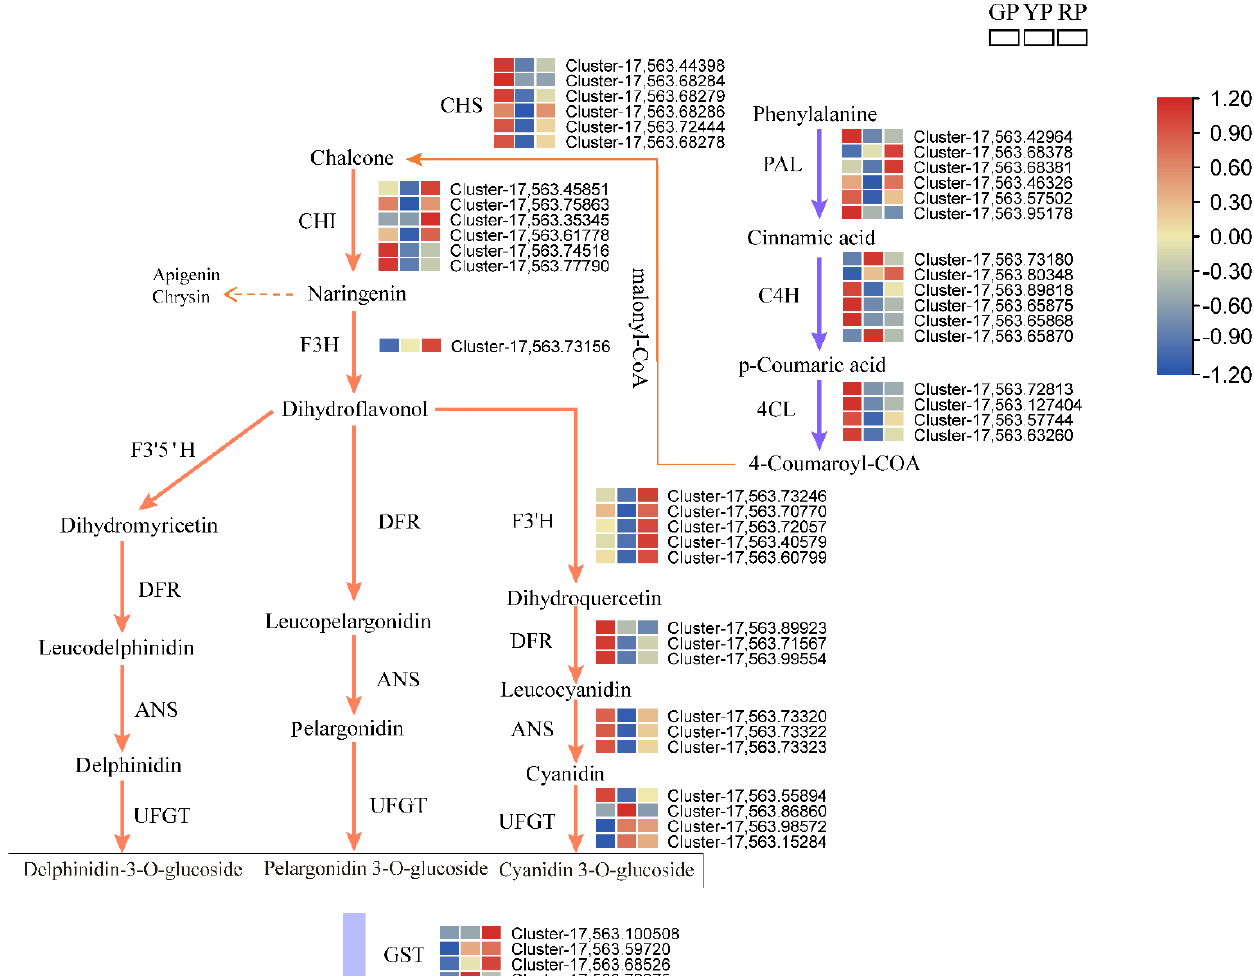
Figure 5. Expression levels of structural genes involved in the anthocyanin biosynthesis pathway in the fruit of the D. delavayi . The heatmap represents the expression of corresponding structural genes in three D. delavayi variations, and in the heatmap, the gradient from blue to red indicates the expression levels of structural genes ranging from low to high. Enzymes in this pathway are annotated as follows: PAL , phenylalanine ammonia lyase; C4H , cinnamate 4-hydroxylase; 4CL , 4-coumarate: CoA ligase; CHS , chalcone synthase; CHI , chalcone isomerase; F3H , flavanone 3-hydroxylase; F3′H , flavonoid 3′ -hydroxylase; F3′5′H , flavonoid 3′,5′ -hydroxylase; DFR , dihydroflavonol 4-reductase; ANS , anthocyanidin synthase; UFGT , UDP-glucose: flavonoid 3-O-glucosyltransferase; 3GT , UDP- glucose: anthocyanidin 3-glucosyltransferase; GST , glutathione S-transferase.